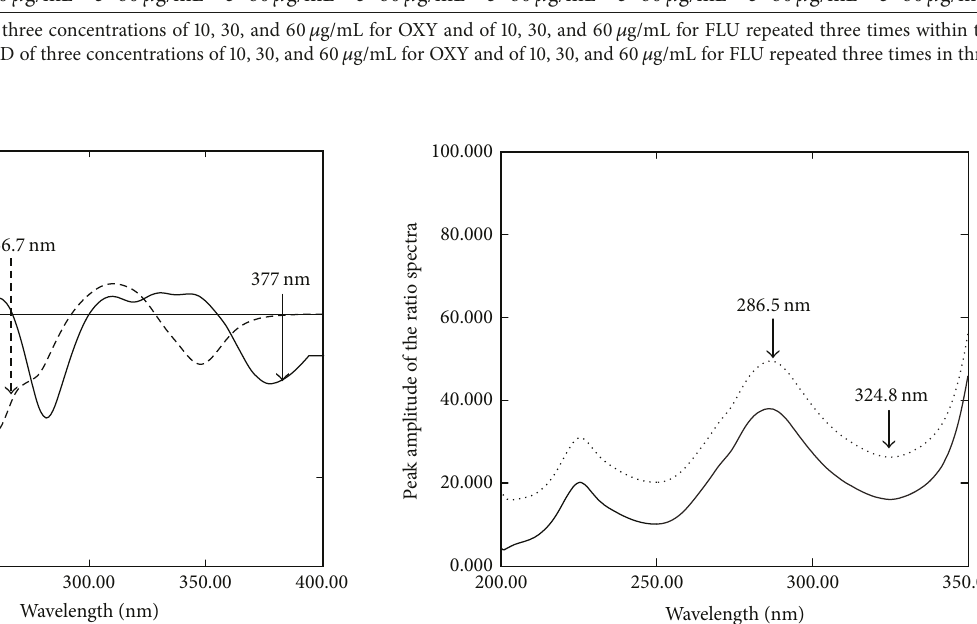
Figure 4: The ratio spectra of 10 𝜇 g/mL OXY (—) and laboratory preparedmixturecontaining10 𝜇 g/mLFLUand10 𝜇 g/mLOXY( ⋅⋅⋅ ) using normalized spectra of FLU as a